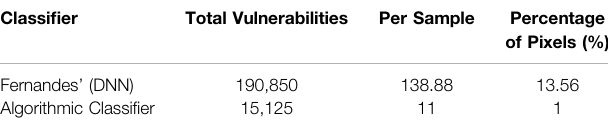
TABLE 2 | Expected number of vulnerability per